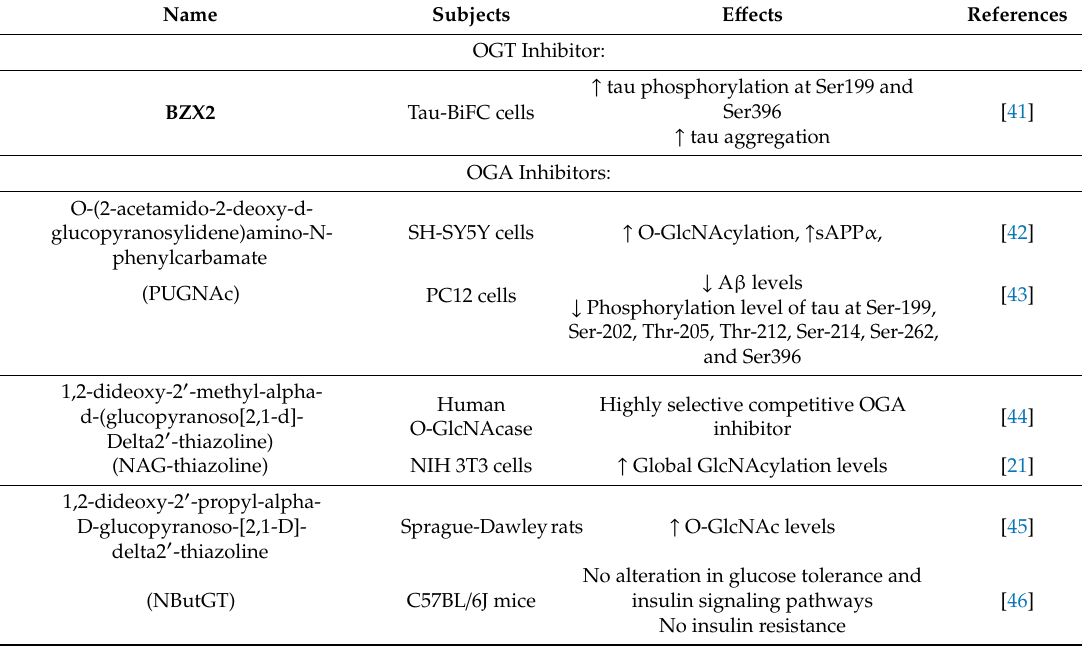
Table 1. E ff ects of OGT and OGA